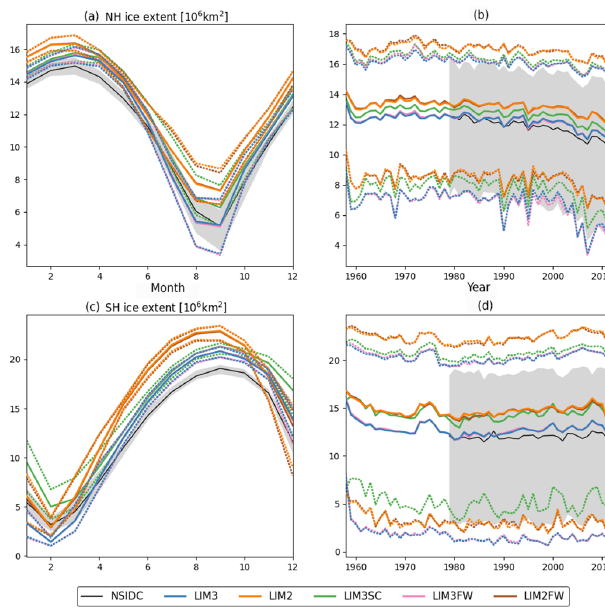
Figure 2. Simulated (coloured lines) and observed (black lines and grey shadings; NSIDC; Fetterer et al., 2002) mean seasonal cy- cle (a, c) of monthly mean sea-ice extent over the period 2003– 2012, for the (a) Northern (NH) and (c) Southern (SH) hemispheres. The sea-ice extent is calculated as the area with sea-ice concentra- tion 15% or more. Dashed lines and grey shadings denote the mini- mum and maximum annual monthly extents during the same period. In the rightmost panels (b, d) , annual maximum, mean and mini- mum time series of simulated and observed sea-ice extents in (b) the NH and (d) SH over the period of 1958–2012 are presented. LIM3 (blue lines) denote the reference LIM3 simulation, LIM2 (orange lines) denote the reference LIM2 simulation, LIM3SC (green lines) denote the LIM3 single-category sea-ice simulation, LIM3FW (ma- genta lines) denote the LIM3 simulation without the freshwater flux adjustments, and LIM2FW (brown lines) denote the corresponding LIM2